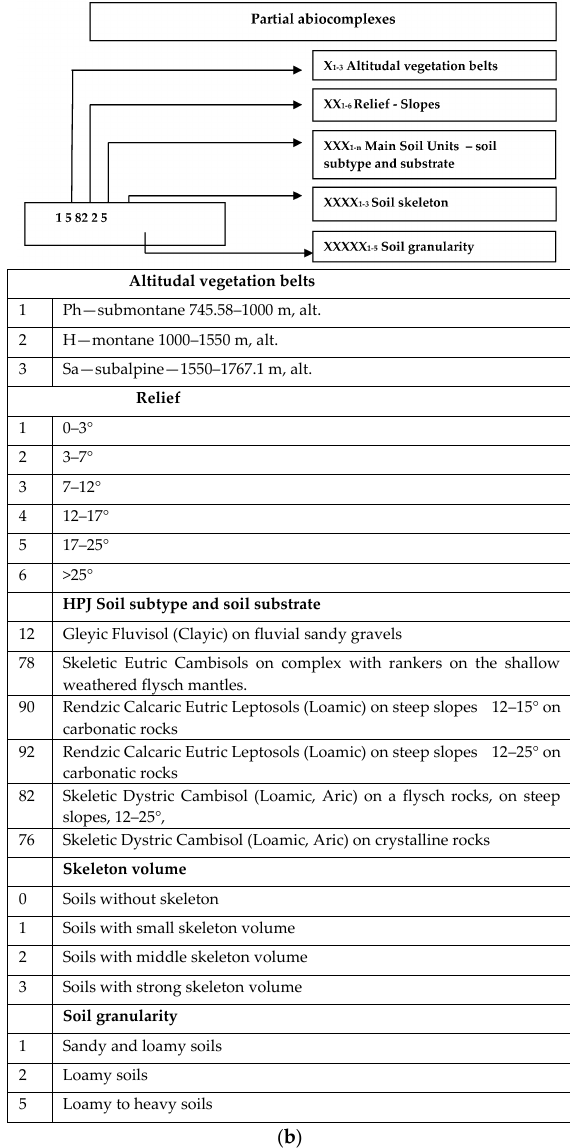
Figure 4. ( a ) Abiotic complexes (ABC) in model area. ( b ) Legend to Figure 4a. Input Analytical Data for LWRC